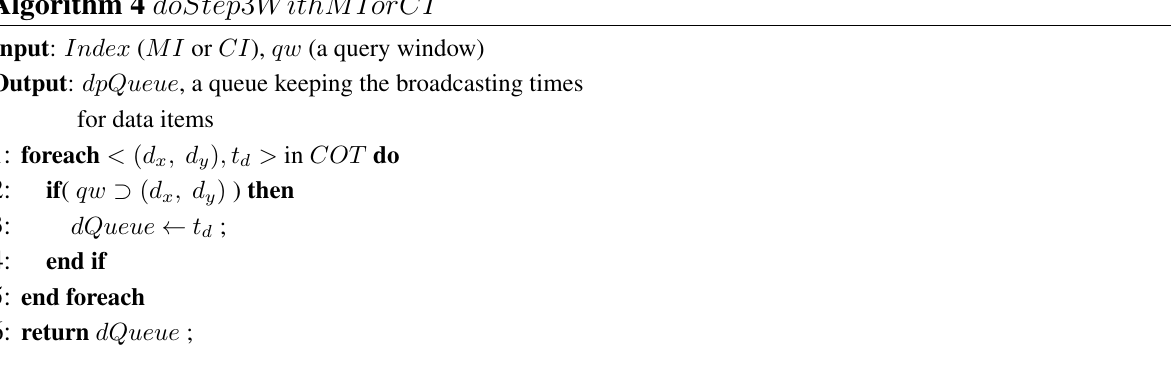
Algorithm 4 doStep 3 W ithMIorCI